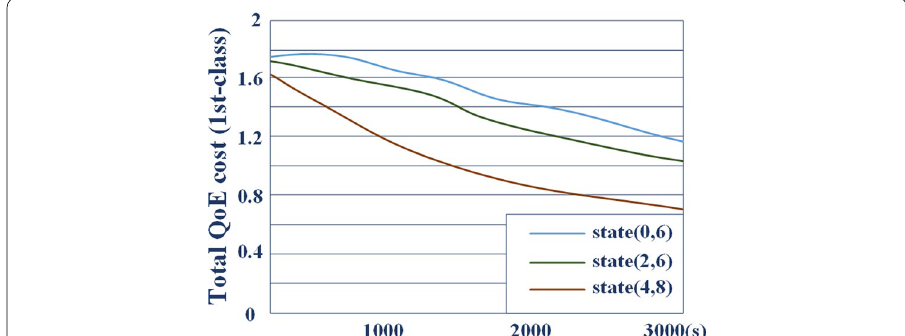
Fig. 11 QoE (class-1) under different initial states